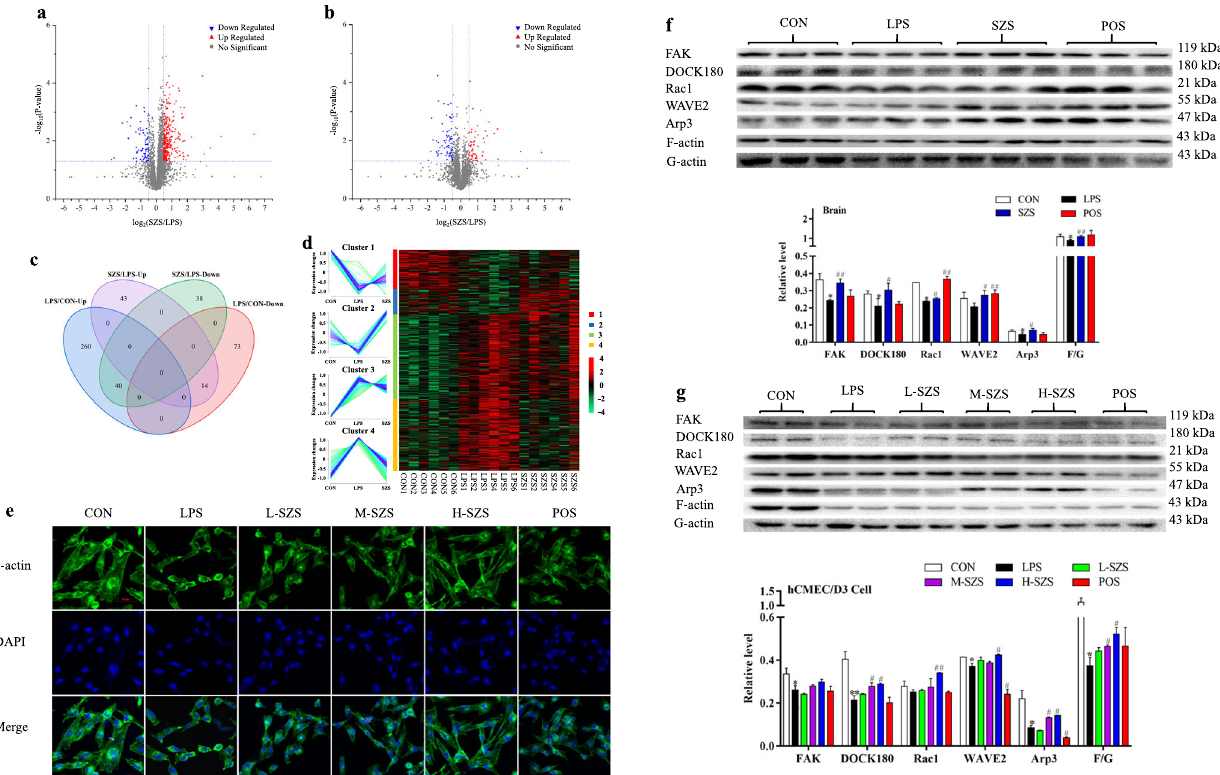
Fig. 4 SZS alters cortex proteins in LPS-exposed rats based on proteomics and regulates the FAK-DOCK180-Rac1-WAVE2-Arp3 signaling pathway. Differentially expressed proteins (DEPs) are shown in volcano maps for the LPS/CON group ( a ), SZS/LPS group ( b ), and the Venn map ( c ). All DEPs were classi fi ed into four clusters and a heatmap ( d ). Immuno fl uorescence (IF) staining was used to examine the expression and distribution of F-actin ( e , the length of scale bars were 50 μ m). The expression of FAK, DOCK180, Rac1, WAVE2, and Arp3 in rat cortex ( f ) and hCMEC/D3 cells ( g ) were determined by western blot analysis. Western blot data were normalized with total protein levels as the internal reference, and the total protein gel is shown in Supplementary Figure 2. All blots or gels derive from the same experiment and that they were processed in parallel. Data are expressed as the mean ± SD ( n = 9). The doses of L-SZS, M-SZS, and H-SZS were 50, 100, and 200 μ g/mL, respectively. Compared with the CON group, * P < 0.05 and ** P < 0.01. Compared with the LPS group, # P < 0.05, ## P <